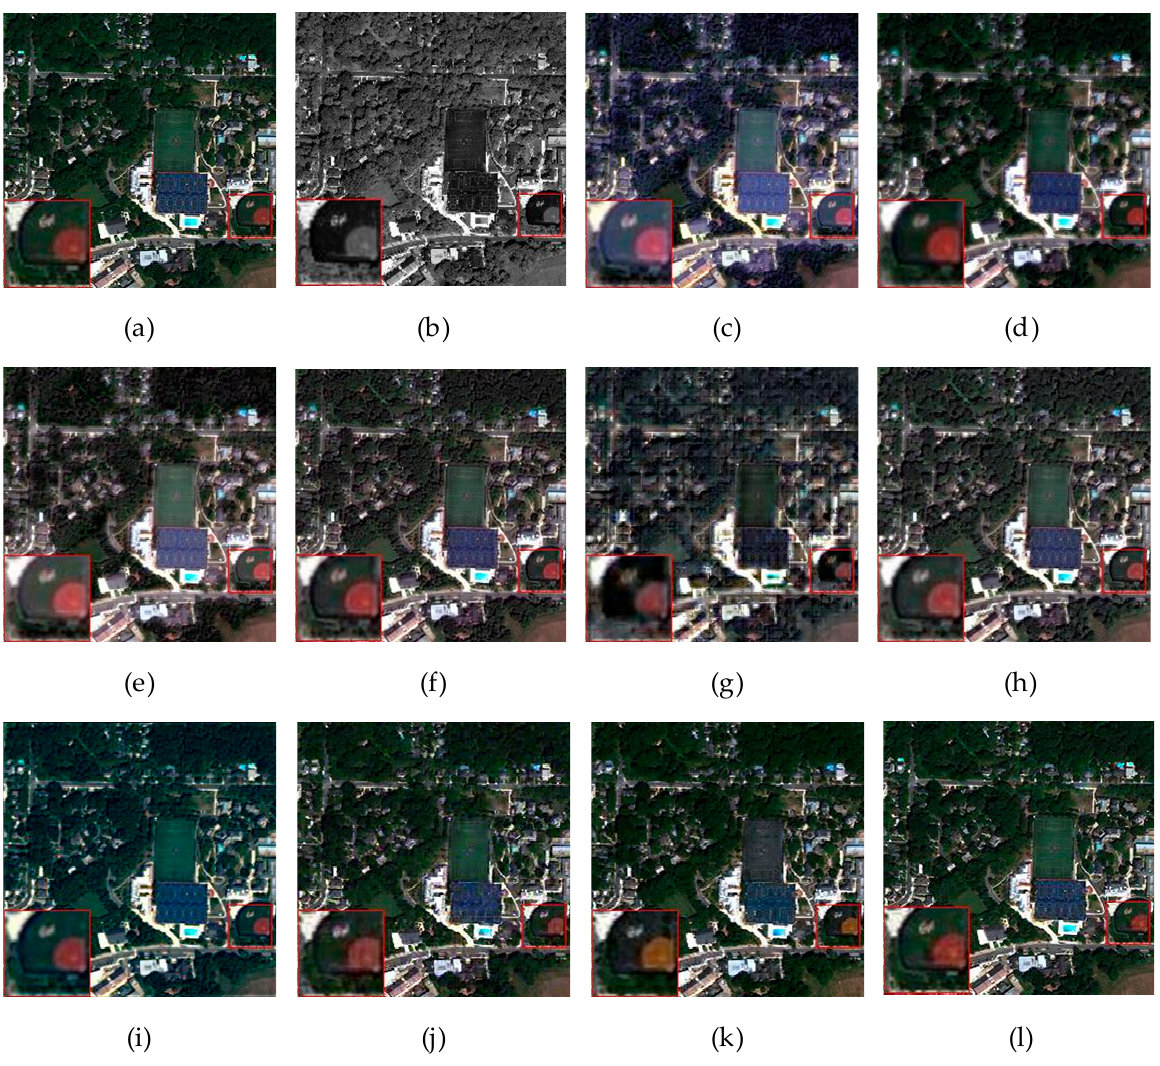
Figure 10. Results of the GeoEye ‐ 1 dataset with eight bands and 256 × 256 size. ( a ) Reference image; ( b ) PAN image; ( c ) HIS; ( d ) PRACS; ( e ) GS; ( f ) HPF; ( g ) DWT; ( h ) GLP; ( i ) SIRF; ( j ) PanNet; ( k ) PSGan; ( l ) MDECNN.